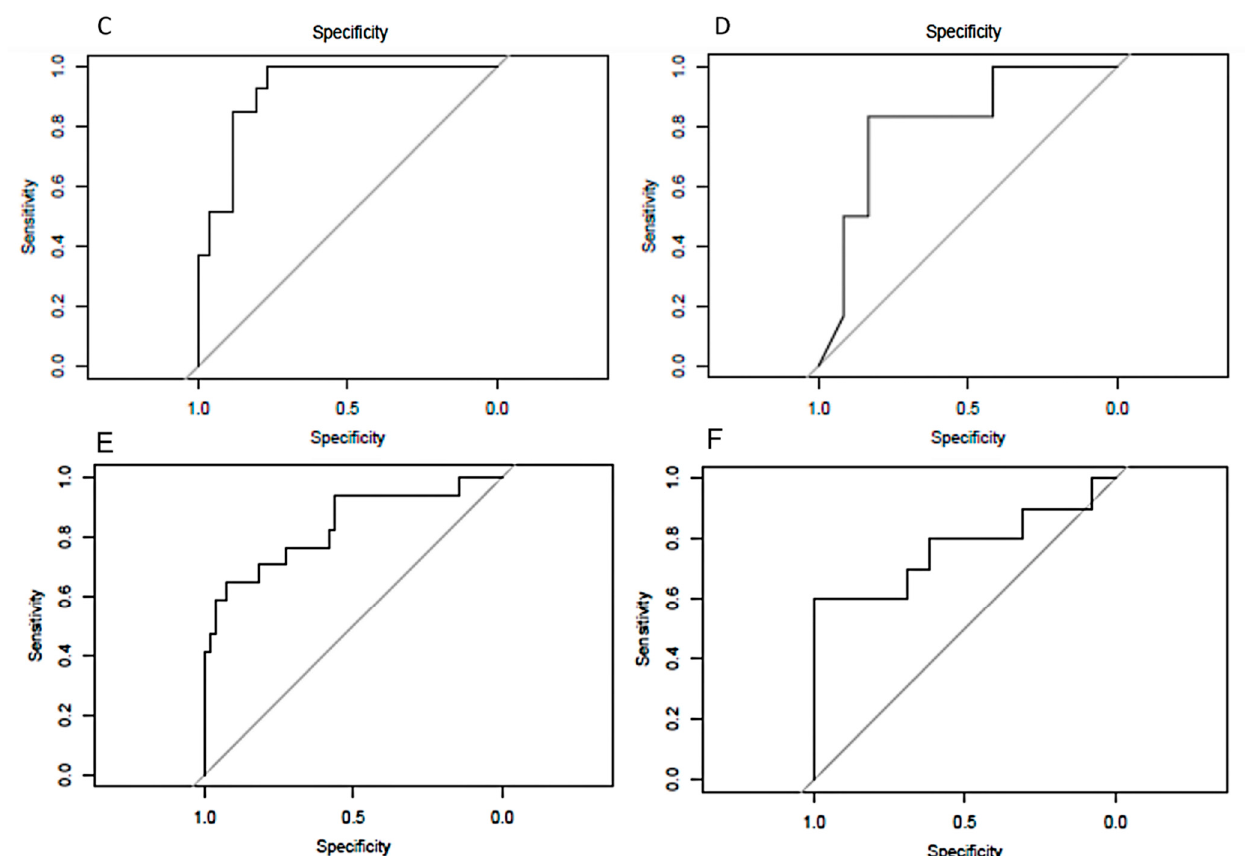
Figure 5. ROC curves of models to predict DMI on the training ( A ) and validation ( B ) sets, to predict LVSI on the training ( C ) and validation ( D ) sets, and to predict low-risk endometrial cancers on the training ( E ) and validation ( F ) sets.